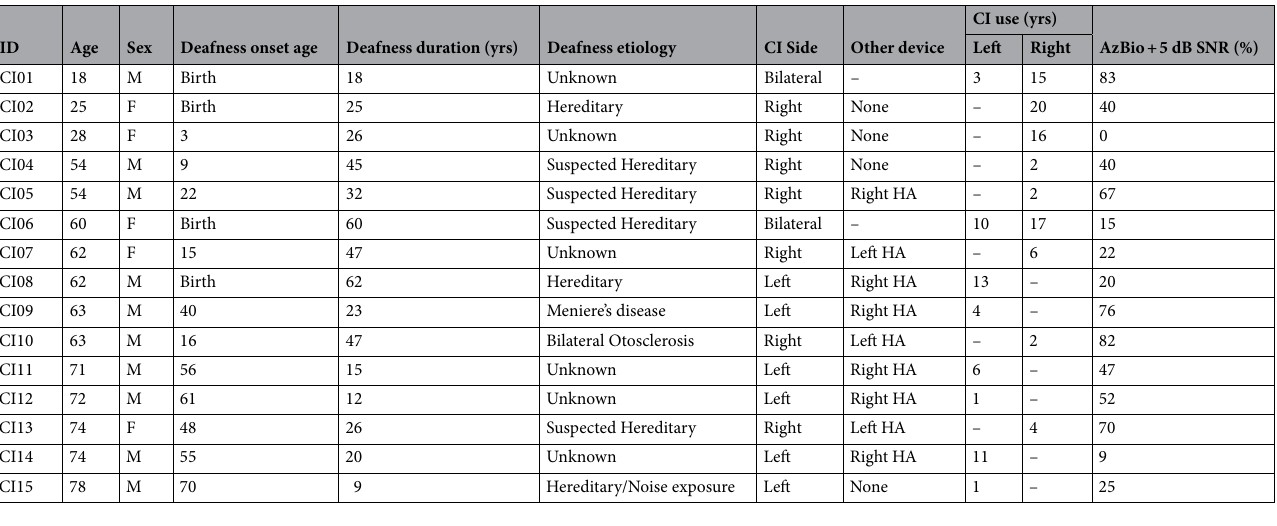
Table 1. Clinical characteristics of CI participants. CI cochlear implant, HA hearing aid, AzBio Arizona Biomedical Institute Sentence List, dB decibels, SNR speech-to-noise ratio, yrs